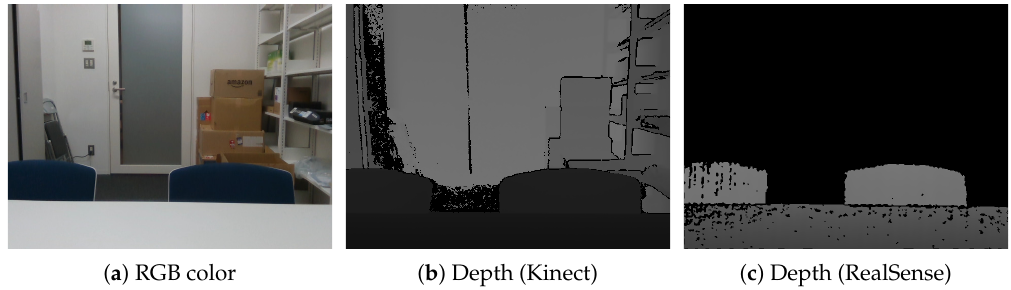
Figure 1. Resultant depth images obtained using different devices. The black pixels in each image define areas where the depth information could not be measured. ( a ) RGB color; ( b ) depth (Kinect); ( c ) depth